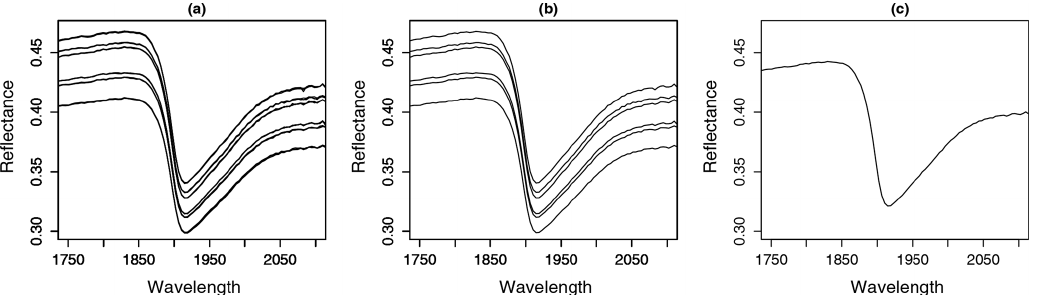
Figure 5. Zoom-in to a sample’s spectral dataset: (a) 18 spectra comprised of 6 replicate sample measurements with 3 scans each, (b) 6 spec- tra related to replicate sample measurements (average of 3 scans each) and (c) 1 averaged spectrum.